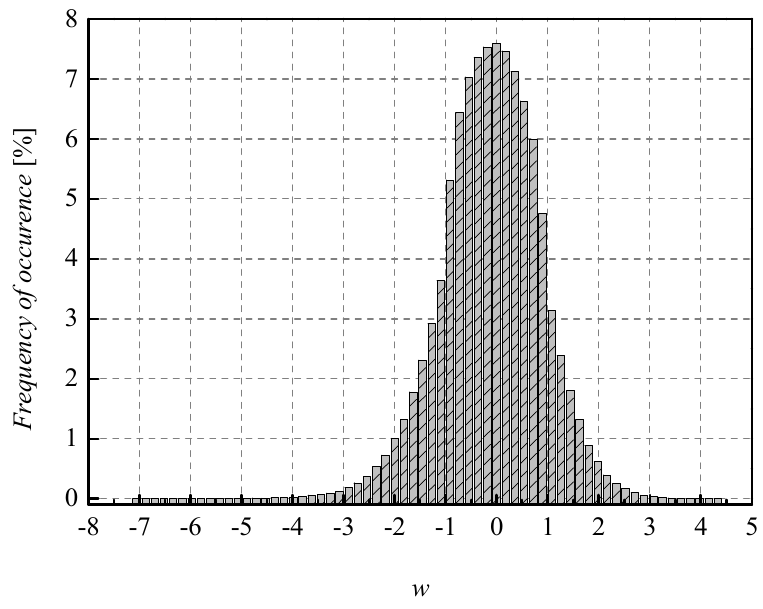
Figure 7. Normalized histogram of weights (FP32) for MLP trained on MNIST dataset. In Case 3, the support region, (cid:60) g , is determined for the iteratively calculated optimal quantization step, ∆ = 0.8504. The support region threshold of SPTQ is defined as follows: x maxSPTQ = 3 ∆ , and x maxSPTQ amounts to 2.5512. This value represents the